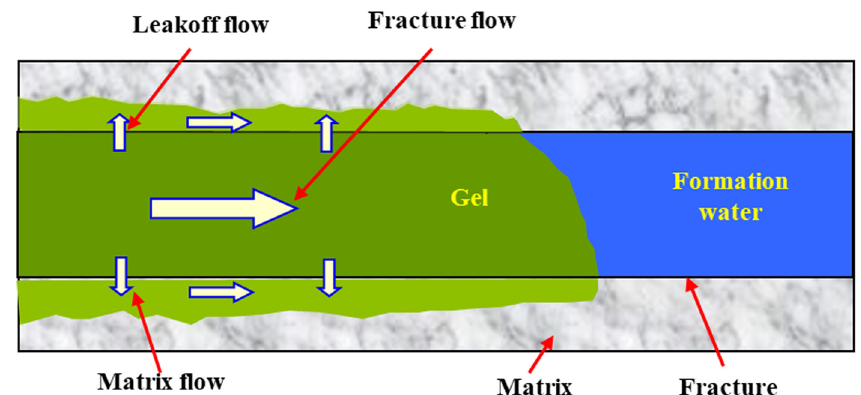
Figure 2: Migration fl ow of gel solution in the fracture and